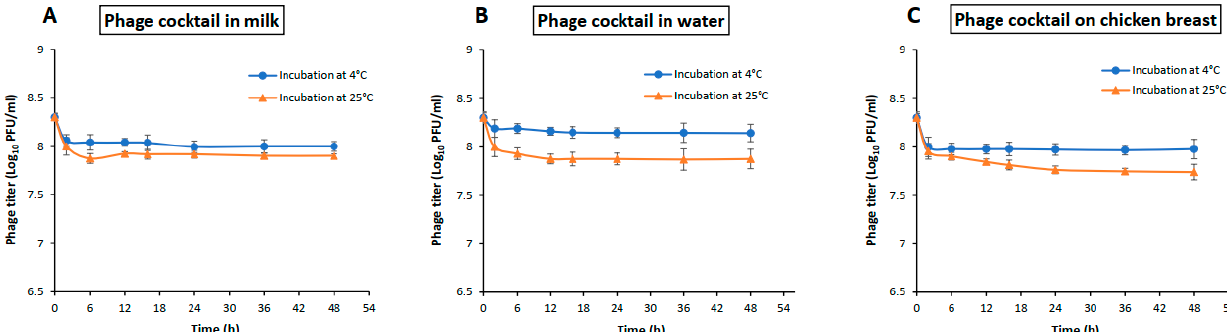
Figure 6. Stability of Salmonella phage cocktail in different food articles. ( A ) Stability in milk, ( B ) stability in water, and ( C ) stability on chicken breast. Phage cocktail titer of 8.3 log 10 PFU/mL was mixed with each food sample and incubated at either 4 °C or 25 °C for 48 h. The values represent mean with a standard deviation of three replicates of each time point.